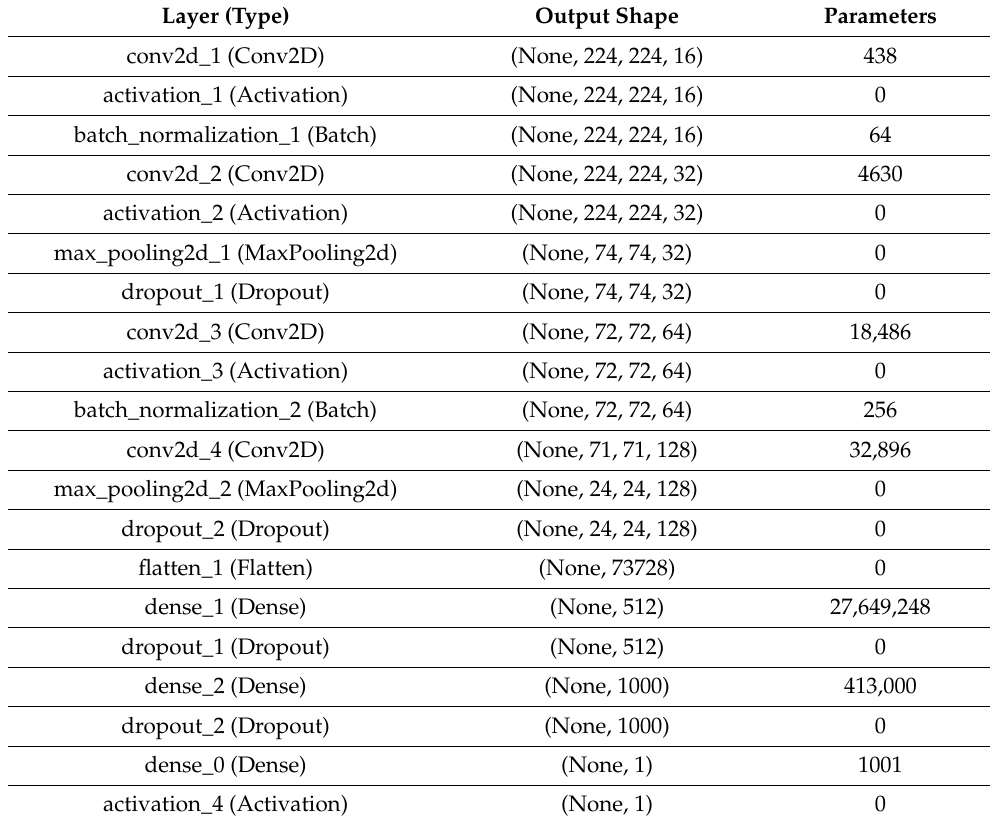
Table 3. The proposed CNN model